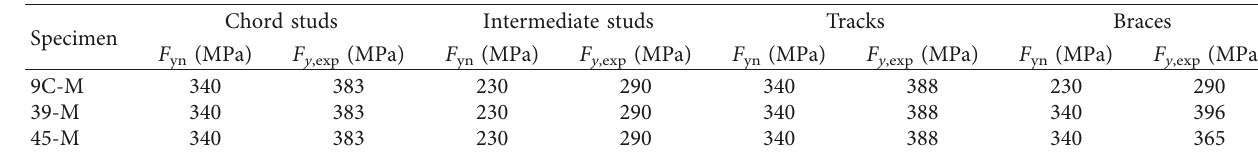
Figure 4: Wall setup (Al-Kharat). Table 2: Material yield stress (MPa).